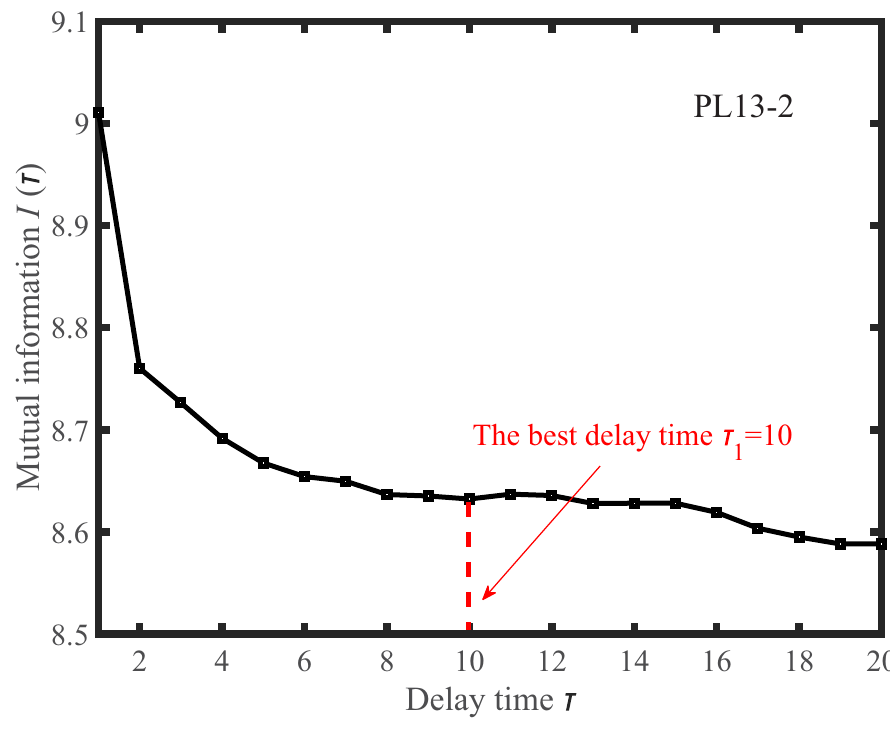
Fig 29. I ( τ ) ~ τ curve for the observed displacement data series of the